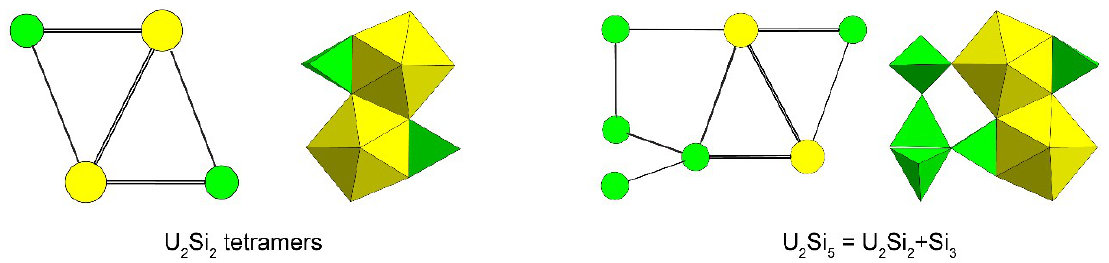
Figure 1. Connectivity in secondary-building-units (SBUs) in natural uranyl silicates shown in ball-and-stick and polyhedral representation (U = yellow, Si = green).